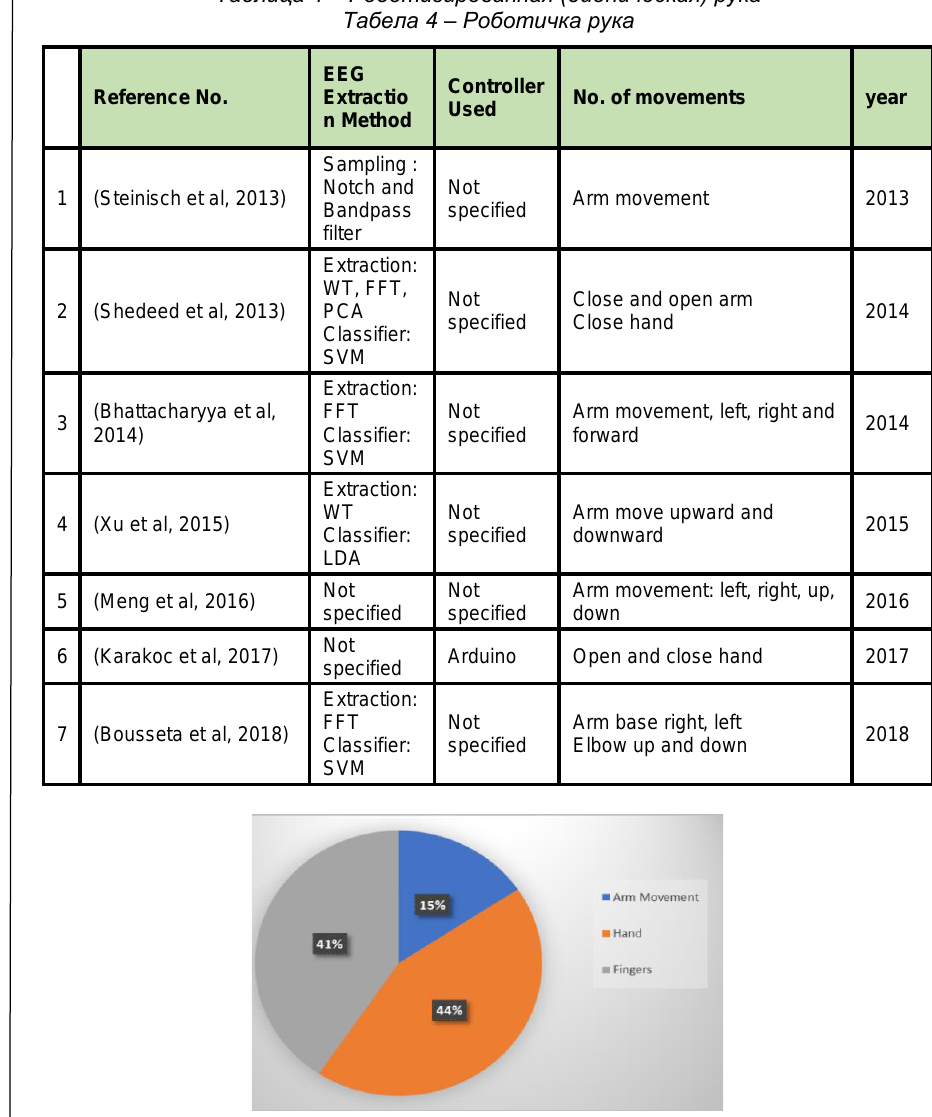
Таблица 4 – Роботизированная (бионическая) рука Табела 4 – Роботичка рука